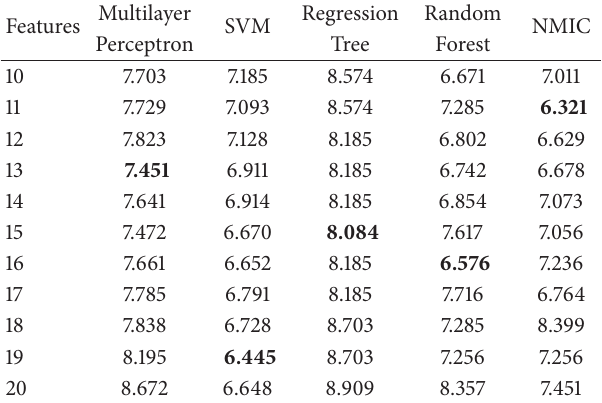
Table 2: Test error or the different regression methods for feature sets ranging from 10 to 20